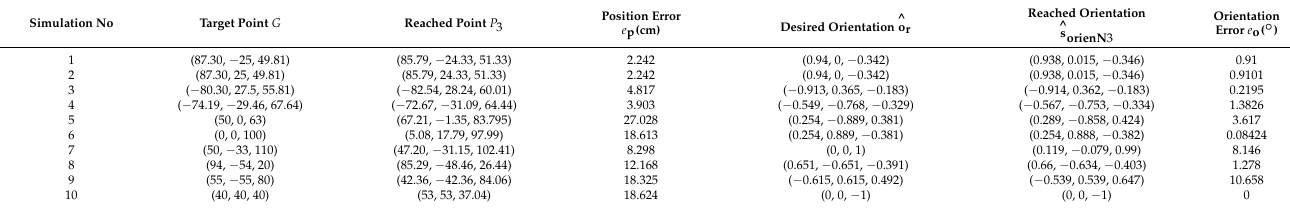
Table 2. Robot orientations and position errors as in the simulations in Figures